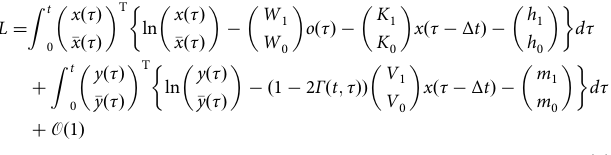
! ! (cid:2) ln ^ K l 1 is a function of